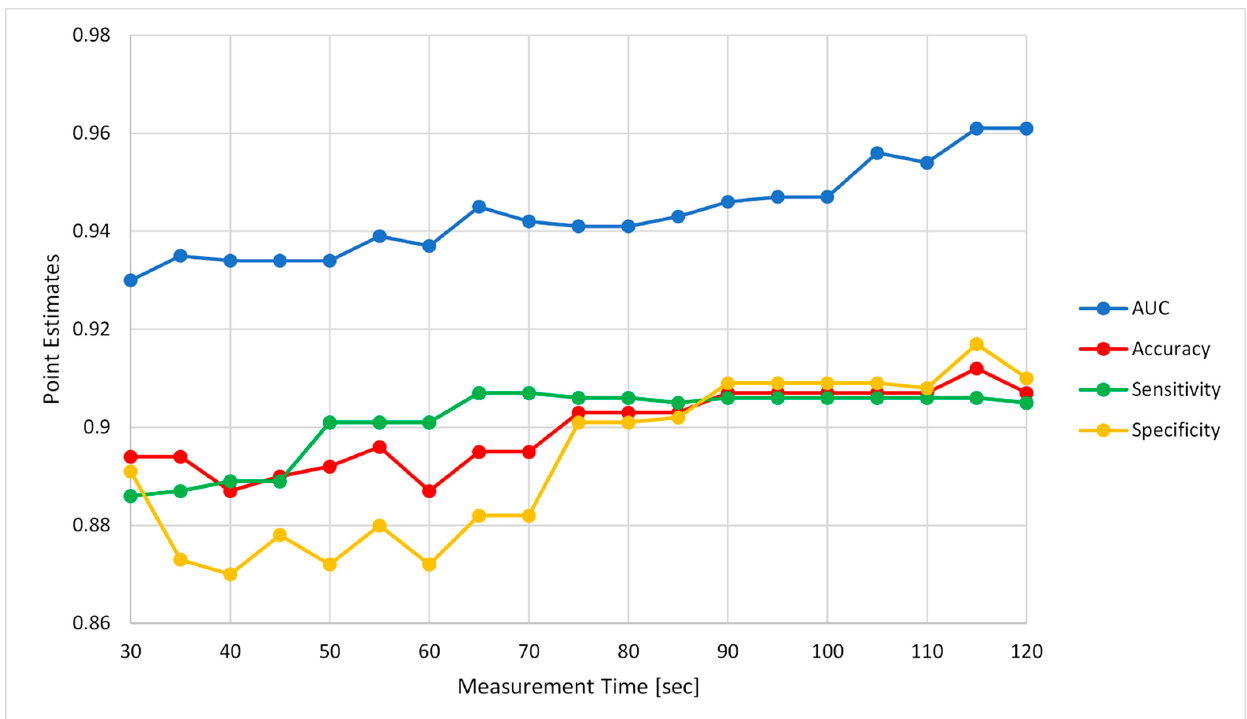
Figure 6. Effect of measurement duration on the algorithm’s performance.